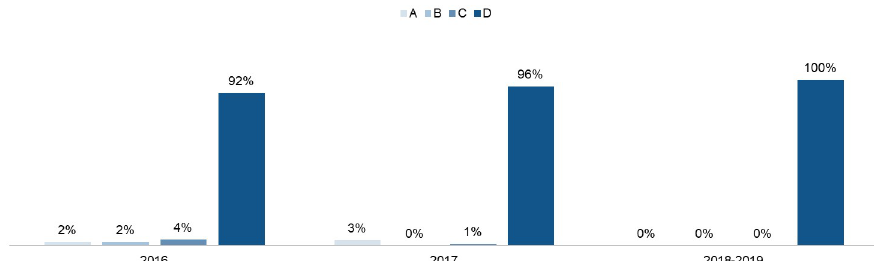
Fig 3. Role performance ratio (2019.6).